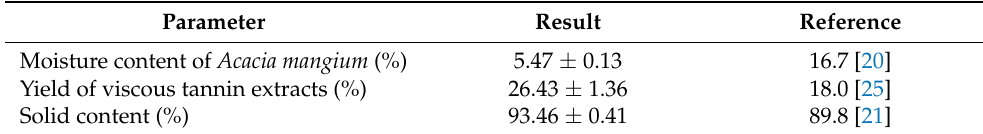
Table 1. Characteristics of extracted